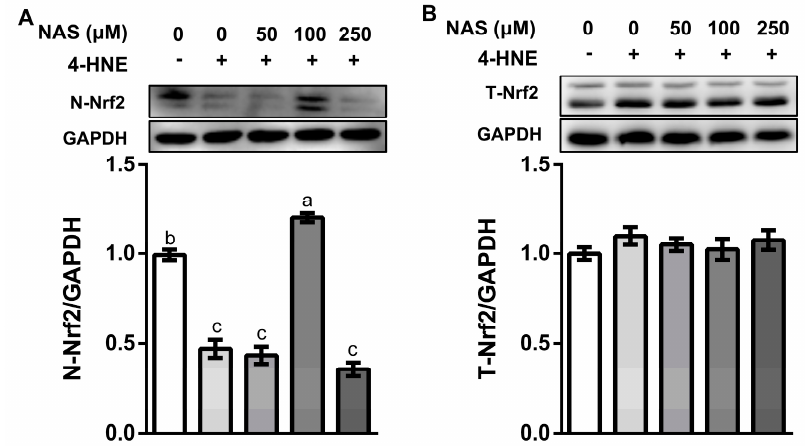
Figure 4. NAS regulated Nrf2 signaling. IPEC-1 cells were treated as described in Figure 2. Protein abundances for nucleus Nrf2 ( A ) and total Nrf2 ( B ) were determined by Western blot analysis. Representative results from three independent experiments were provided, and values are means ± SEMs, n = 3. Means without a common letter differ, P < 0.05.